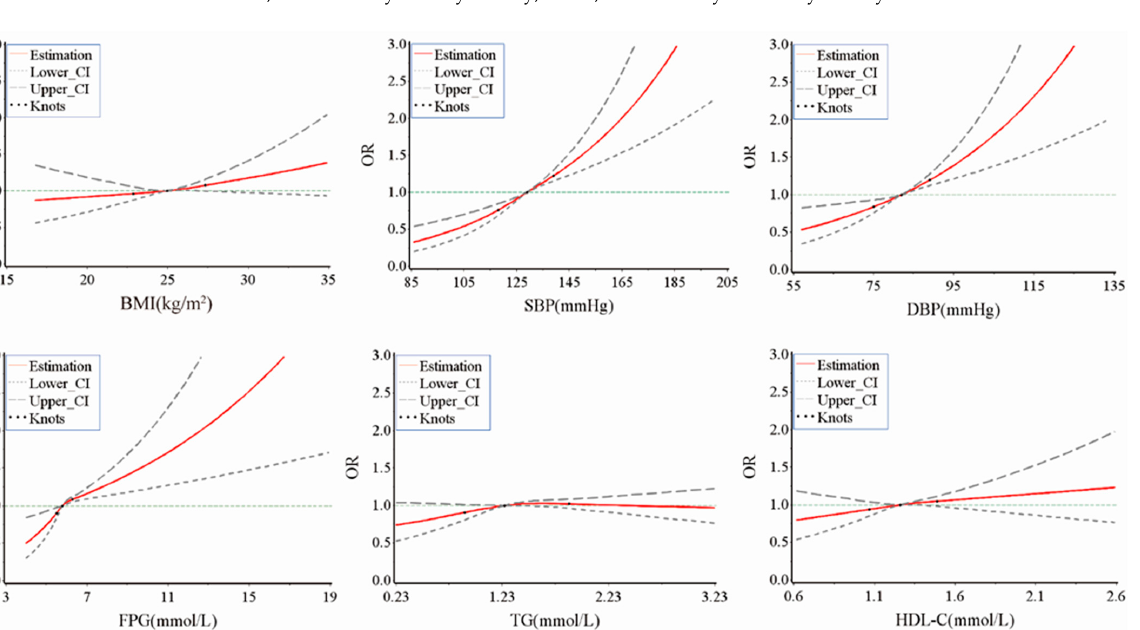
Table 4. Multifactorial logistic regression analyses for carotid plaque according to the obesity phe- notypes and inflammation.